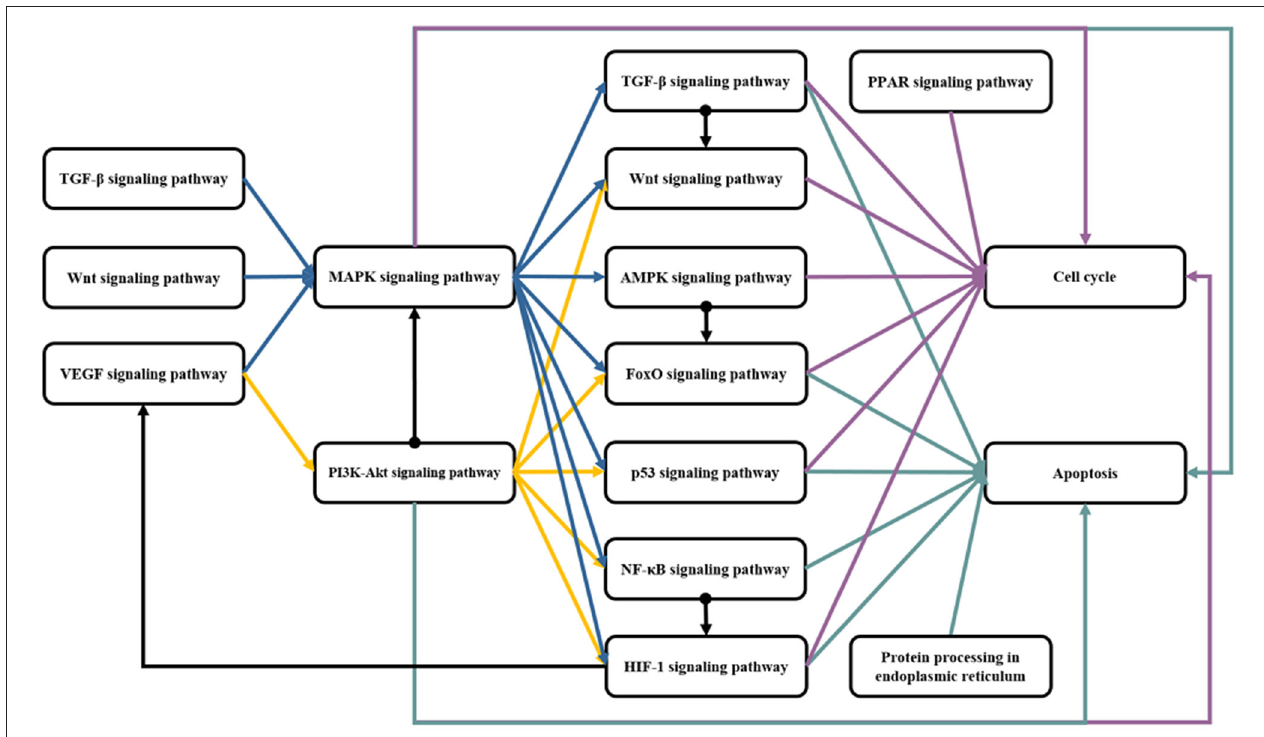
FIGURE 2 | The crosstalk among the signaling pathways related to pharmacological mechanism of rhein. The pathways related to rhein are initiated by the membrane receptors of several pathways. Then, MAPK and PI3K-AKT parallel signaling pathways are activated, and several downstream pathways are affected, thereby eventually regulating cell cycle and apoptosis. Blue line is the crosstalk of MAPK signaling pathway; Yellow line is the crosstalk of PI3K-AKT signaling pathway; Purple line is the crosstalk of cell cycle; Green line is the crosstalk of apoptosis; Black line is the crosstalk of other